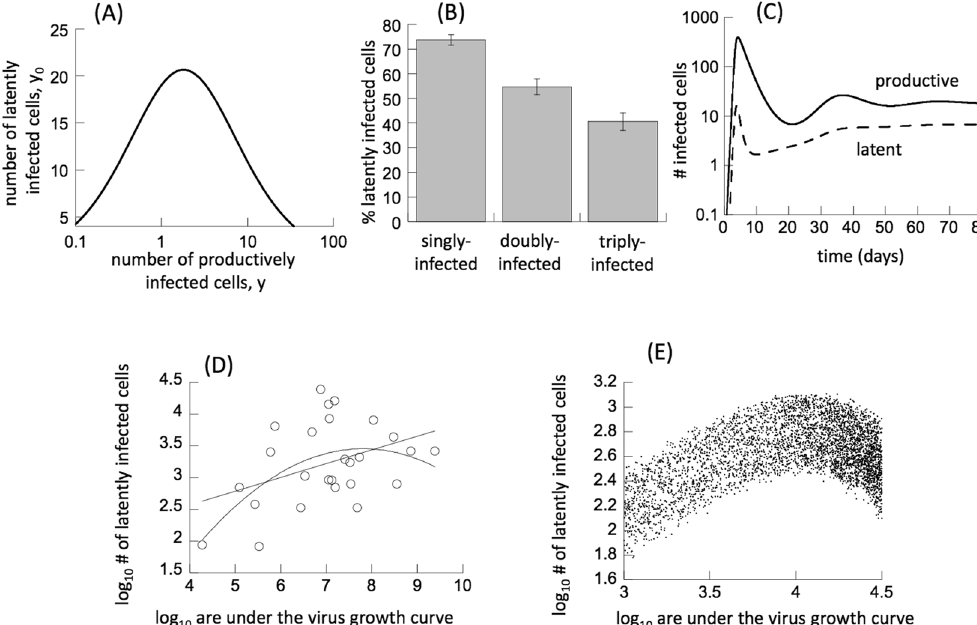
Figure 1. ( A ) Basic properties of model (1). The death rate of infected cells, a, was varied (from a = 0.1d − 1 to a = 1d − 1 ), and the relationship between the equilibrium number of latently and productively infected cells was plotted. λ = 10 d − 1 , d = 0.015 d − 1 , a 0 = 0.003 d − 1 , g = 0.001 d − 1 , β = 0.0057/(dayxcells), q = 0.95, f = 1/7. Higher values of the death rate parameter a can be thought of representing a CTL response that reduces the life-span of infected cells. ( B ) In vitro latency following infection of Jurkat T cells with fluorescent reporter viruses. Plotted is the calculated percentage of latently infected cells (those without a productive virus) among all cells that are singly, doubly, and triply infected. Details of data and calculations are given in the Supplementary Materials. The average from six replicas of the experiment was determined, and standard errors are shown. According to t-tests, the difference was significant comparing the average percentage among singly and doubly infected cells (p = 0.039), among singly and triply infected cells (p = 0.00049), and among doubly and triply infected cells (p = 0.032). ( C ) Acute infection dynamics, predicted by model (1). λ = 10 d − 1 , d = 0.015 d − 1 , a = 0.45 d − 1 , a 0 = 0.003 d − 1 , g = 0.001 d − 1 , β = 0.0057/(dayxcells), q = 0.95, f = 1/7. ( D ) Data replotted from reference 24: As in the original paper, a straight line was fitted through these data (p = 0.04). Also, a polynomial function can be fit through these data, describing a one-humped relationship (p = 0.006). The linear model has a slightly lower Akaike information criterion (AIC) value than the polynomial model, with a difference of only Δ = 0.38. ( E ) Relationship between the number of latently infected cells and the area under the virus growth curve, according to stochastic Gillespie simulations 36 of model (1). For each realization of the simulation, parameters were chosen randomly from a uniform distribution, assuming a range of + / − 10% of the base values. Each dot represents one realization. The time at which measures were determined was also randomly chosen in the range between 1 and 11 days. The base parameters are: λ = 100 d − 1 , d = 0.003 d − 1 , a = 0.45 d − 1 , a 0 = 0.003 d − 1 , g = 0.001 d − 1 , β = 0.000114/(dayxcells), q = 0.95, f = 1/7. Parameters were adjusted compared to other figures to ensure persistence in the stochastic